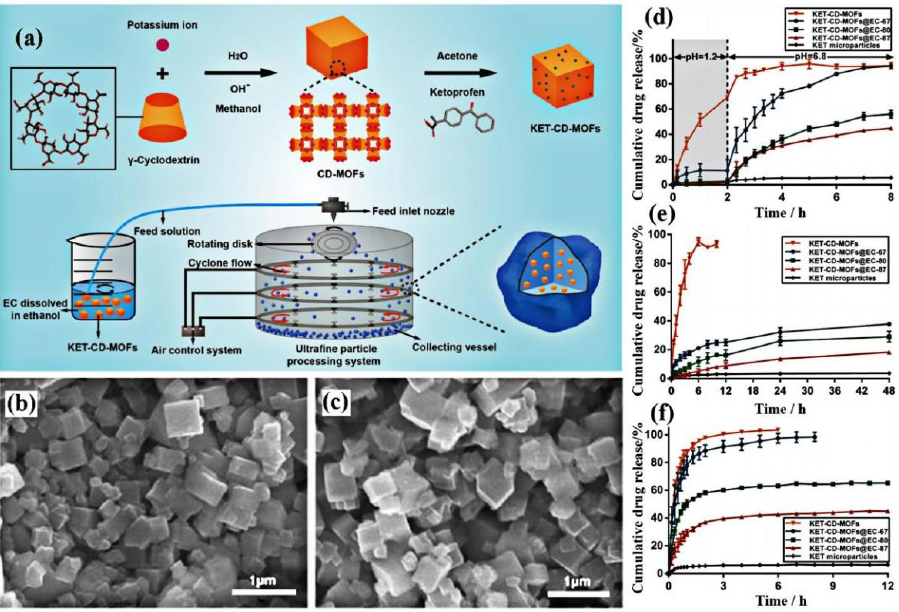
Figure 8. ( a ) Preparation, ( b , c ) characterization, and ( d – f ) drug delivery of CD-MOFs and KET-CD- MOFs. Reproduced with permission from Ref. [80], copyright (2019) the American Chemical Soci- ety.